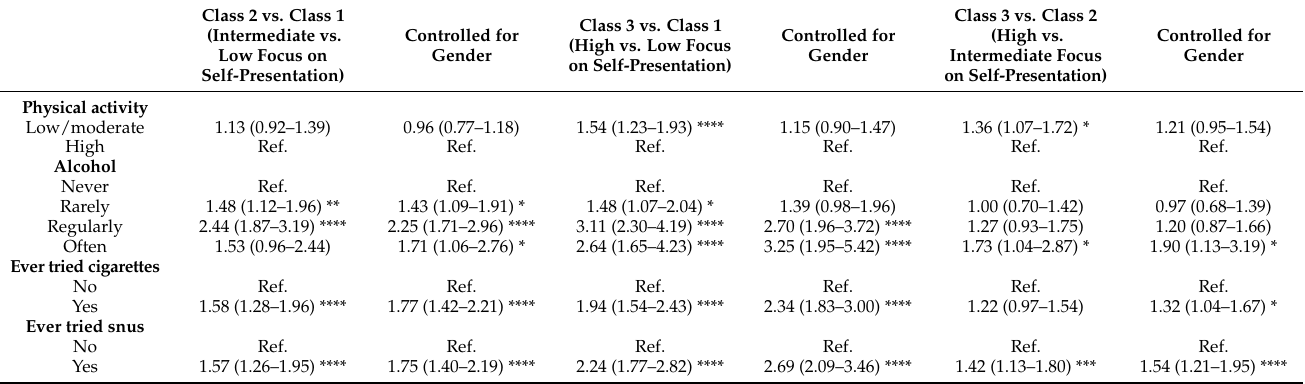
Table 6. Comparison of class belongingness across lifestyle